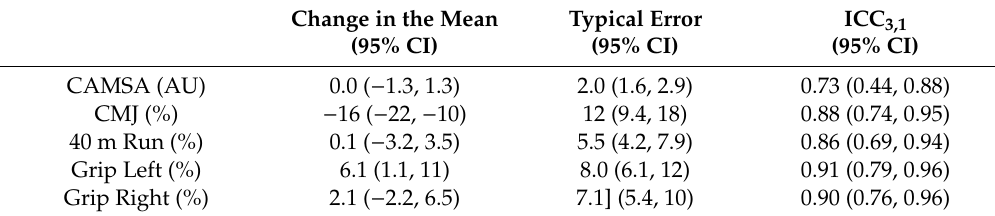
Key: Confidence interval (CI); Inter-class correlation coe ffi cient (ICC 3,1